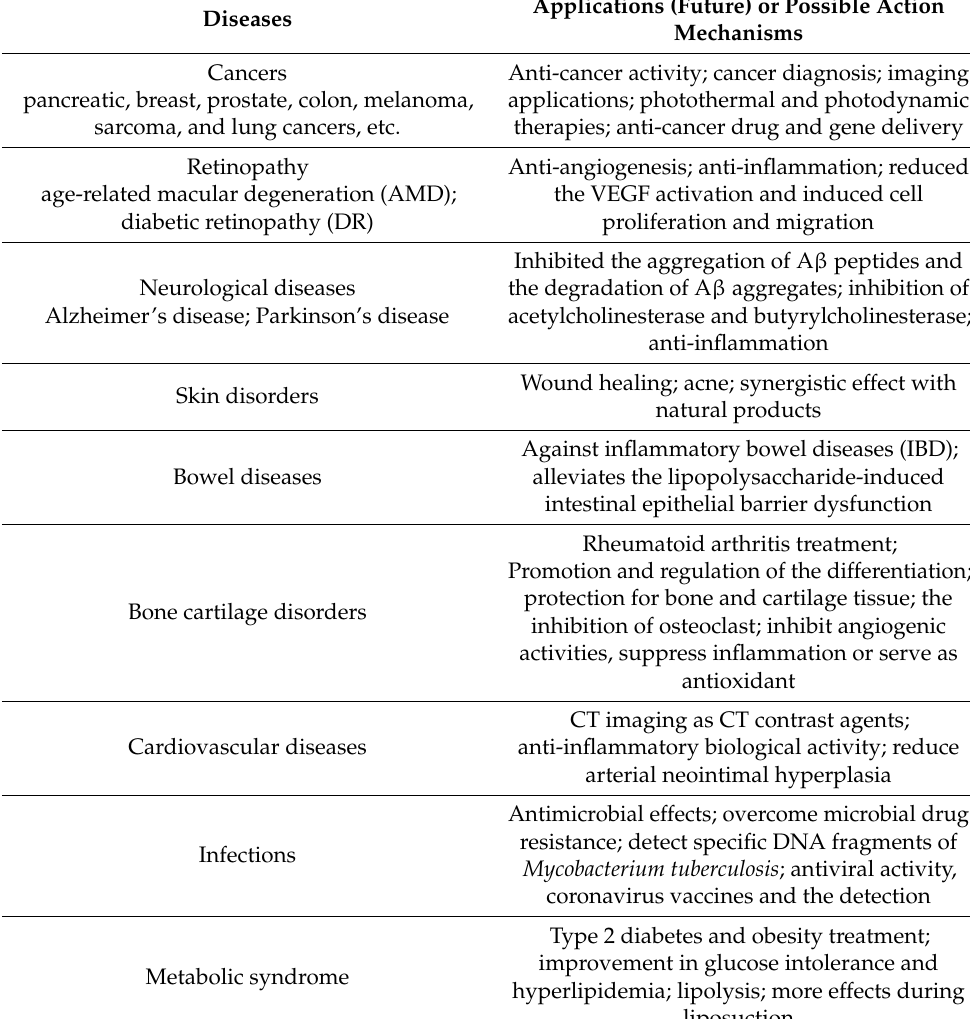
Table 1. Summary of the effects and mechanisms of gold nanoparticles in diseases.